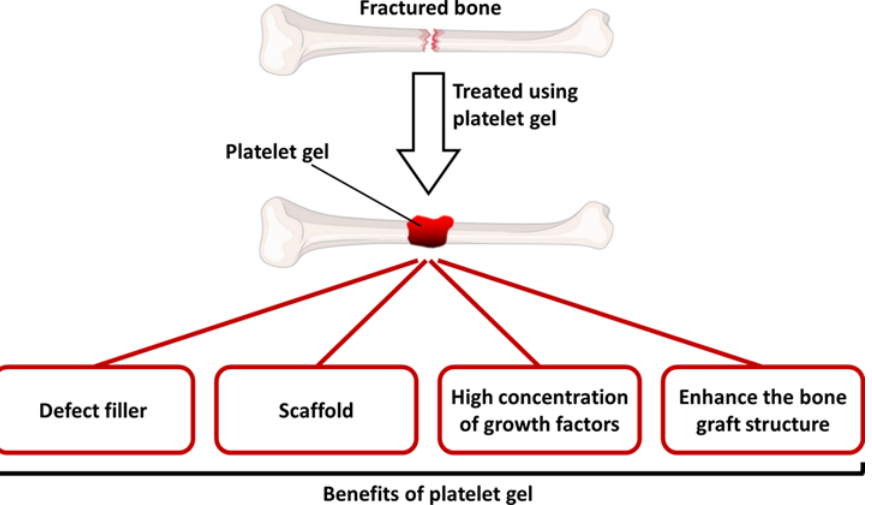
Figure 2. Different from fluid-like platelet-rich plasma, platelet gel is a gel-like material rich in platelets as its name suggests and is rapidly formed when platelet-rich plasma is mixed with activators such as thrombin and calcium chloride.